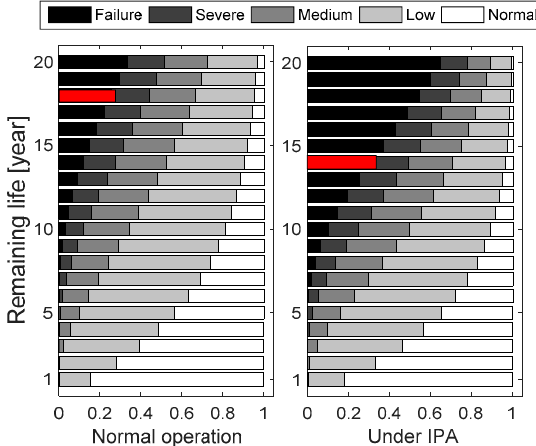
Figure 10. Probability distribution of bearing state.